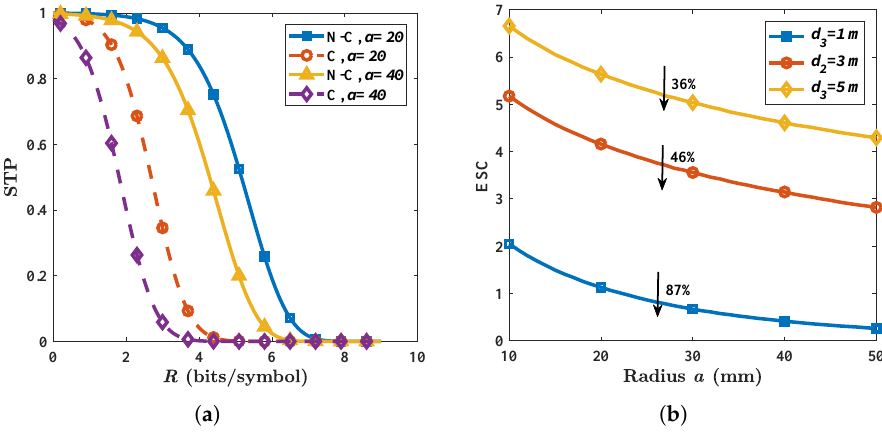
Figure 6. ( a ) Influence of radius a on STP. ( b ) ESC versus radius a under different PEC location d 3 . The solid line describes the non-colluding case while the dashed line describes the colluding case. Other parameters are given by: G = 25 dBi; N = 3; f = 300 GHz; P = − 10 dBm; R S = 15 m; and λ p =